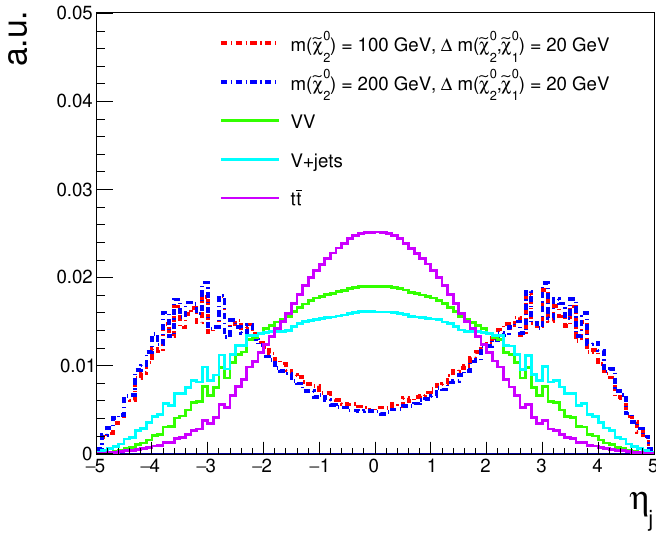
Figure 3 . η distribution for jets with p T > 30 GeV, for two benchmark signal points and ma- jor backgrounds.